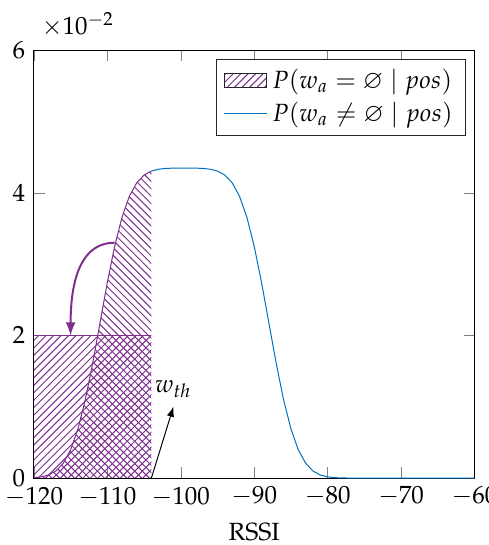
Figure 3. The extension of our sensor model incorporates uncertainty on the antenna gain, by a convolution with a uniform